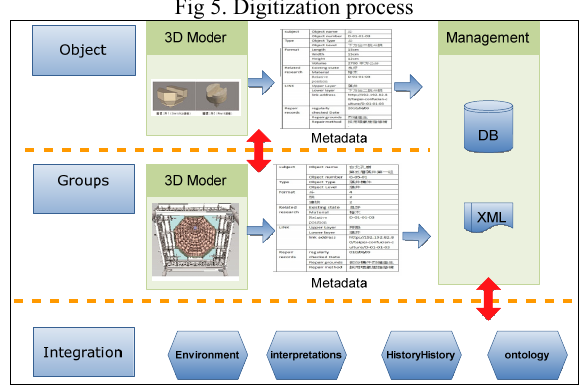
Fig 5. Digitization process